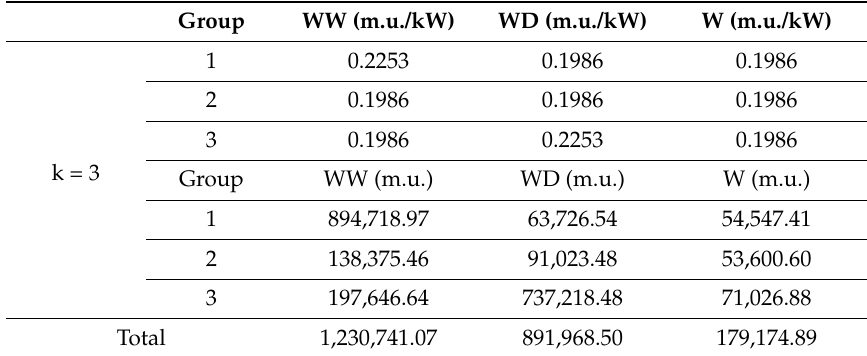
Table 3. Tariffs and Final Remuneration to all scenarios, for k =